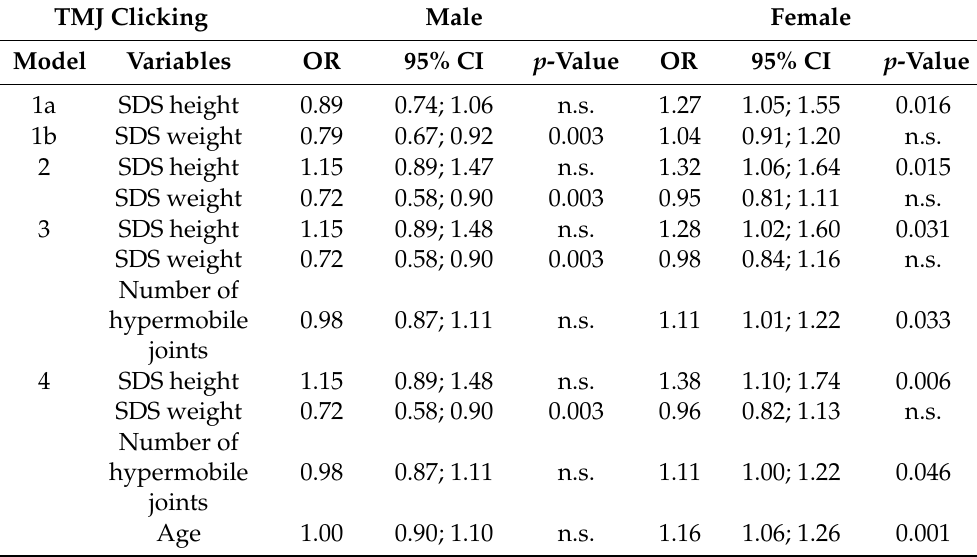
Table 4. Multivariable analyses of TMJ clicking (N = 309) in relation to physical variables; SDS: standard deviation scores, OR: odds ratio, CI: confidence interval, n.s.: not